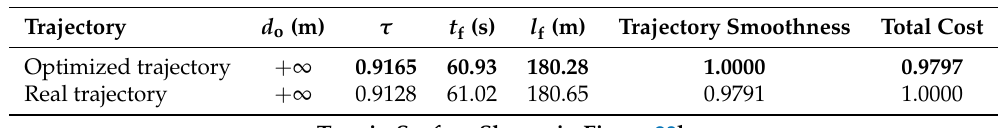
Figure 23. The trajectories (green) after optimization and the real trajectories (blue) of the vehicle in the real world. Table 9. The performance comparison of the trajectories shown in Figure 23. Note that the real trajectories were often different between different runs, so the data of the real trajectories were averaged over 50 runs. Terrain Surface Shown in Figure